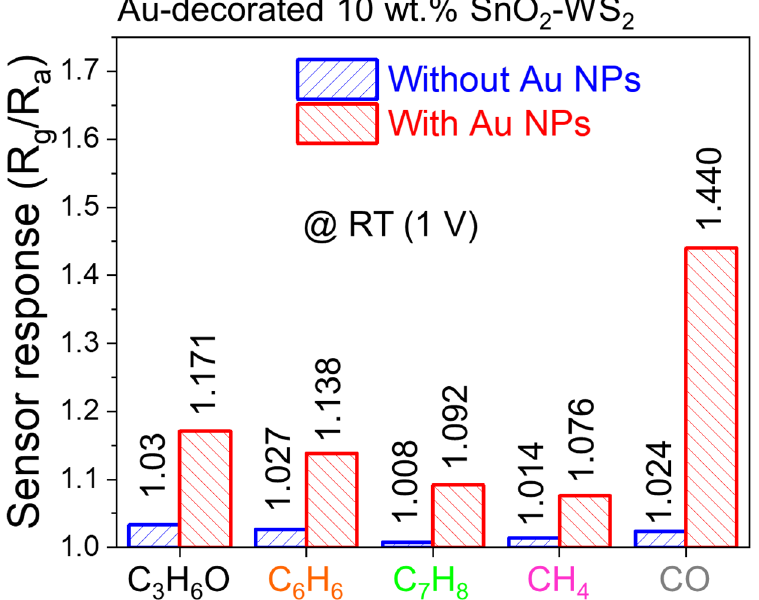
Figure 5. Selectivity pattern of Au-decorated 10 wt% SnO 2 –WS 2 composite gas sensor without and with Au NPs measured under 1 V applied voltage at 20 ◦